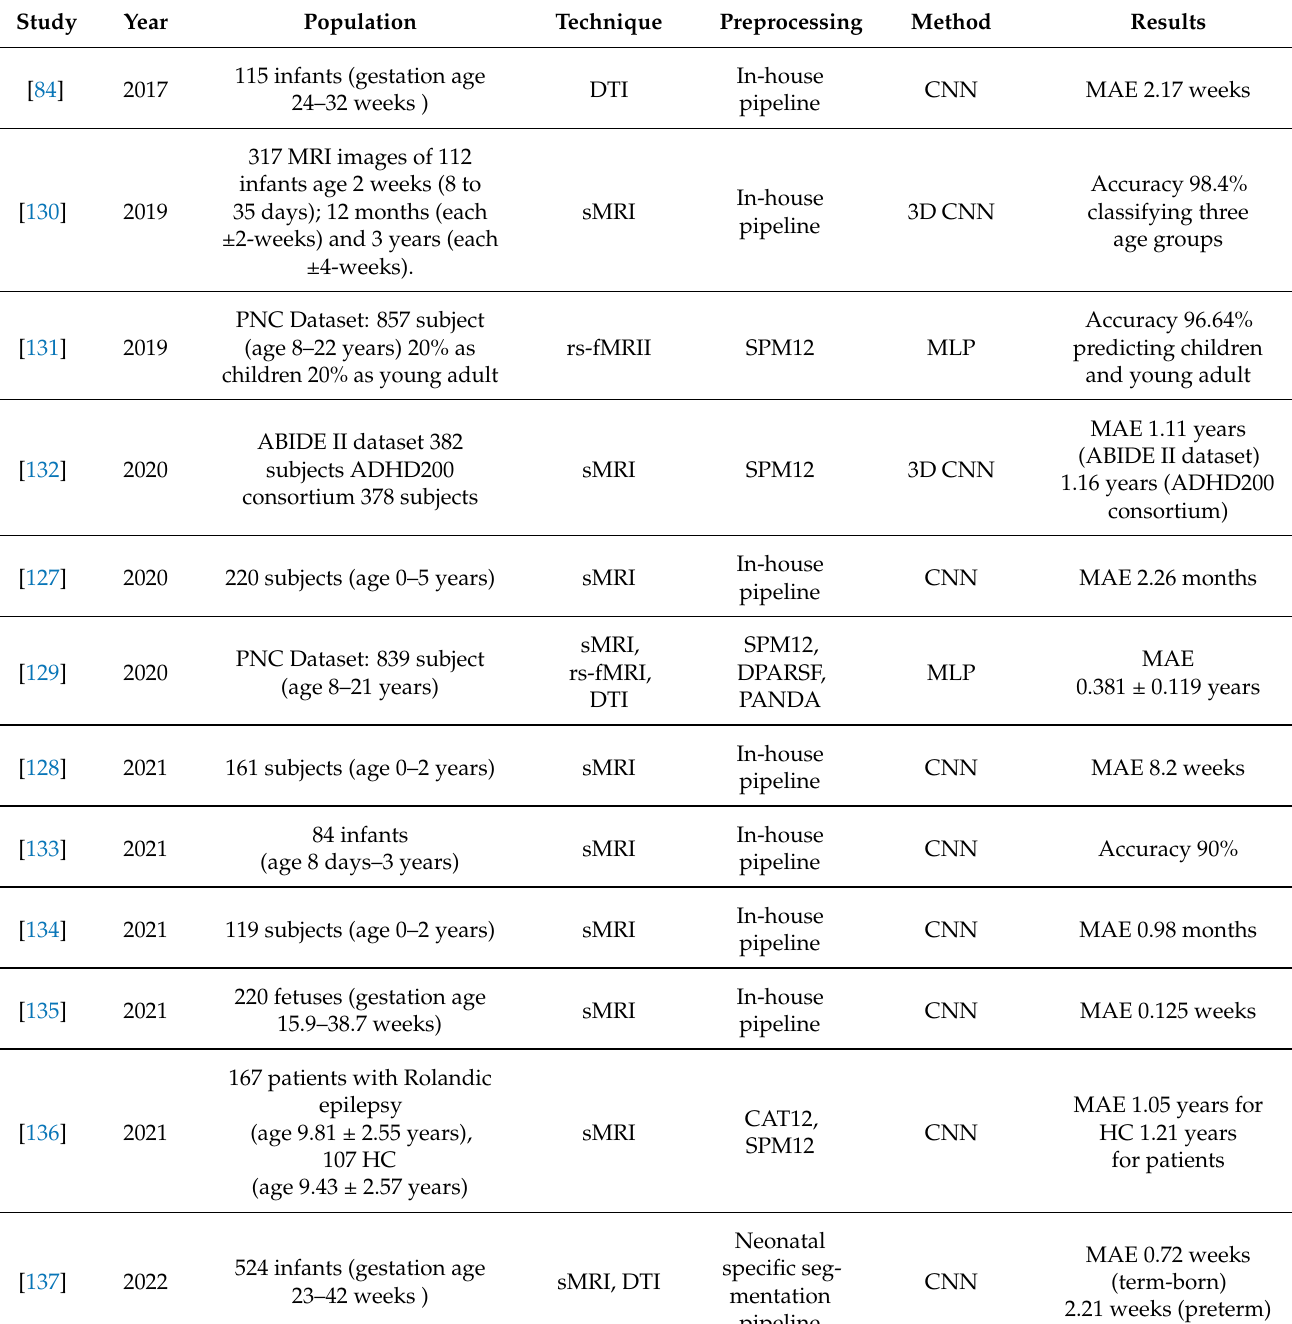
Table 4. Predicting brain